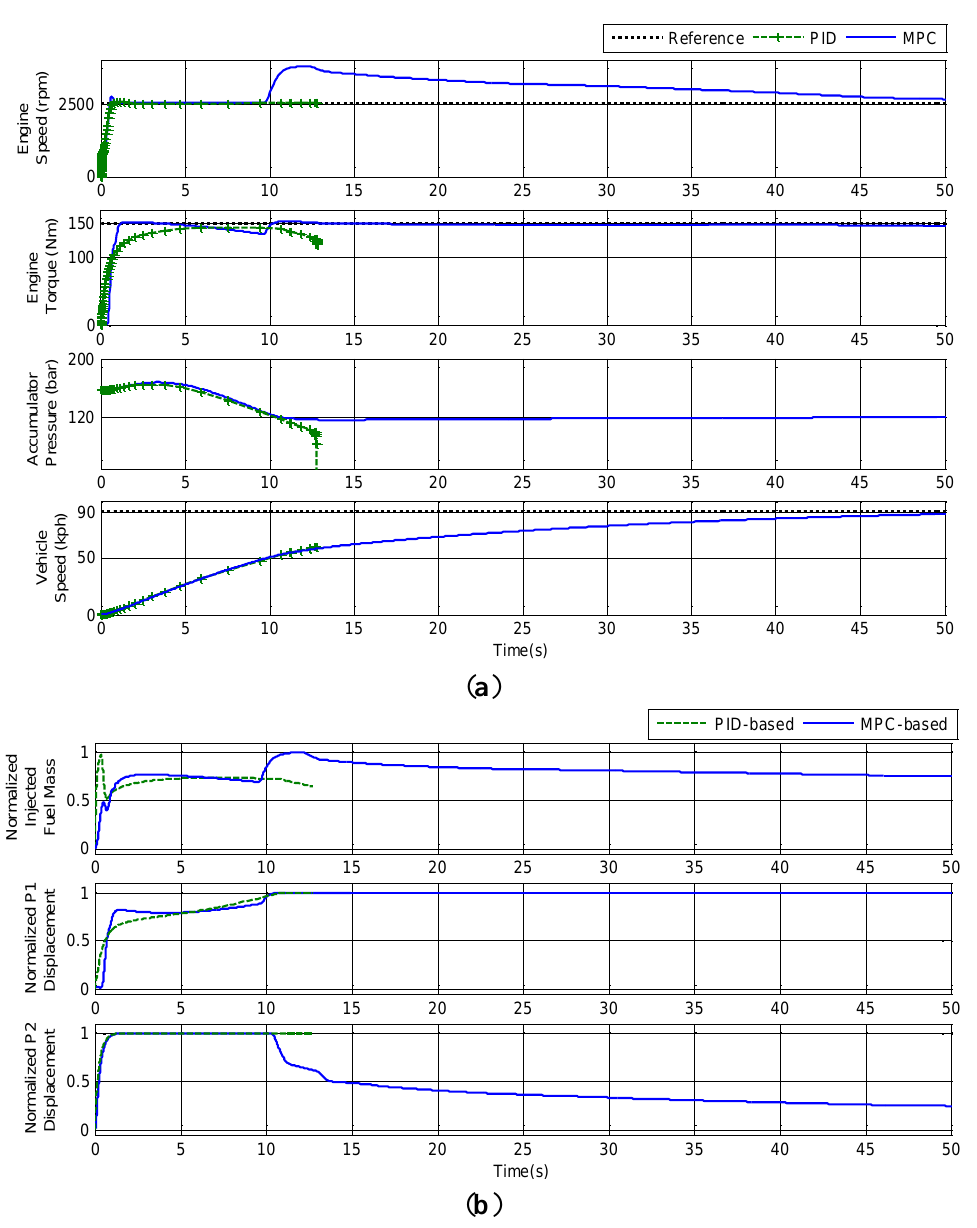
Figure 13. The behaviors of the SHHV with a high speed demand: ( a ) Outputs; and ( b )